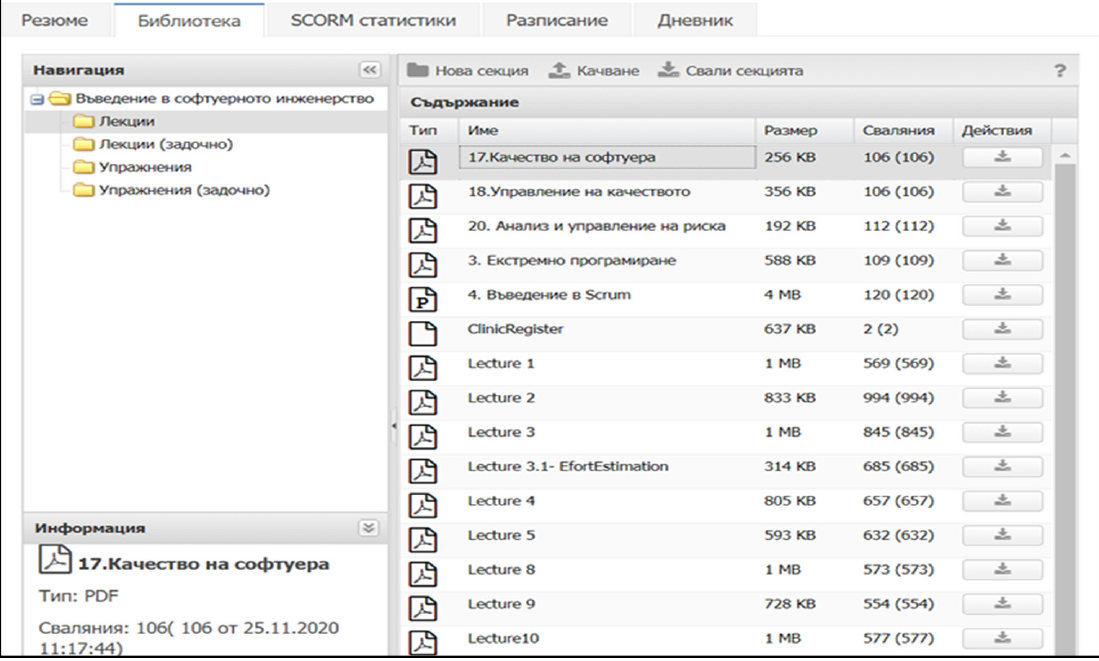
Figure 1. Library module in DeLC 2.0 (in Bulgarian).